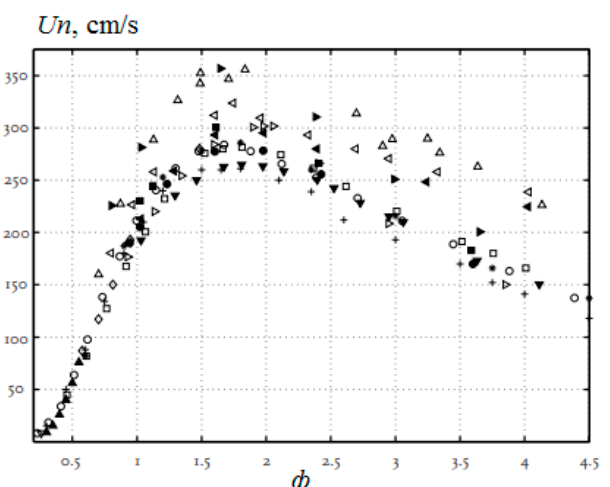
Figure 1. Dependence of the normal flame velocity Un of hydrogen–air mixtures on the equivalence ratio under normal conditions according to the results of various studies, which are represented by various symbols (Adapted from ref. [17]).